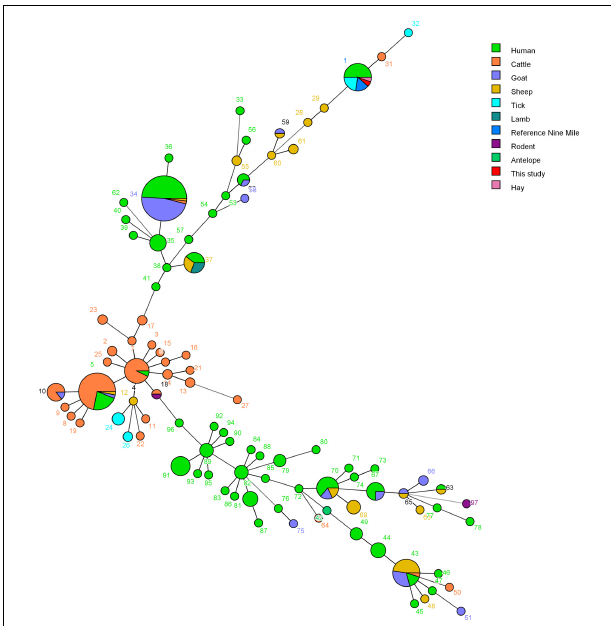
FIGURE 7 | Minimum spanning tree of Coxiella burnetii strains using a six-multiple locus variable number tandem repeat analysis. The obtained MLVA genotypes identified in this study and data of 304 strains based on the MLVA-6 database (http://mlva.i2bc.paris-saclay.fr/mlvav4/genotyping/) were used. Each circle represents a unique genotype (1–97). The minimum spanning tree of the analyzed isolates provides information on the proportion of hosts of each identified genotype (see color index), and the size of the pie charts represents the number of isolates of the corresponding